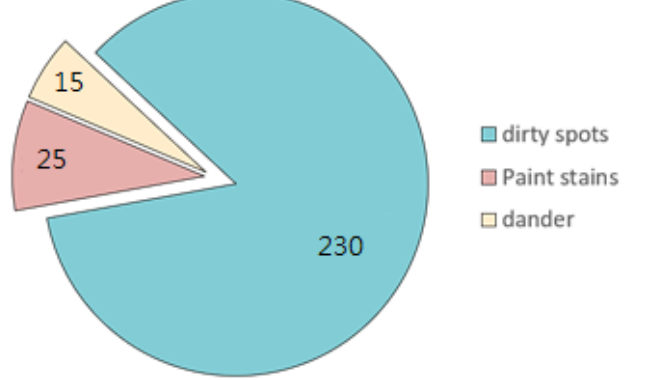
Figure 15. Distribution of defect types as percentages.